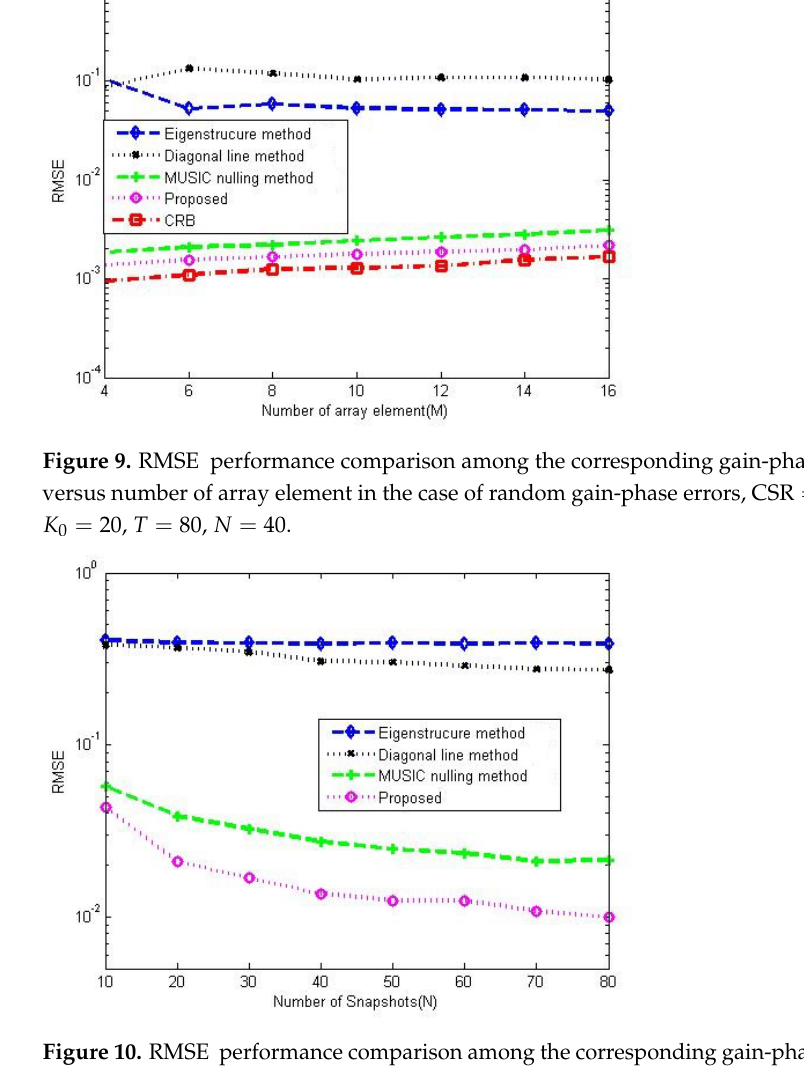
Figure 10. RMSE performance comparison among the corresponding gain-phase estimation methods versus number of snapshot in 5-element ULA with deterministic gain-phase errors, CSR = 30 dB, SNR = 20 dB, K 0 =